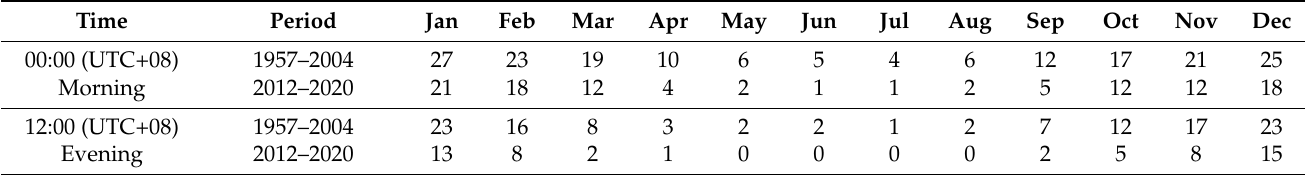
Table 3. Recent changes in the number of days with a near-surface temperature inversion over Ulaanbaatar city.